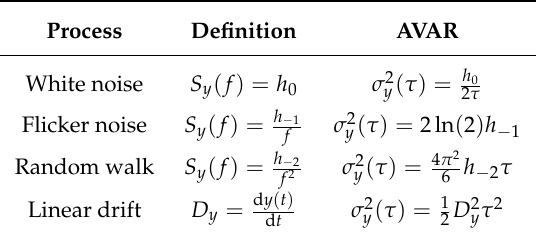
Table 2. Relations between the definitions of various noise processes and drift and the expressions for the Allan variance.